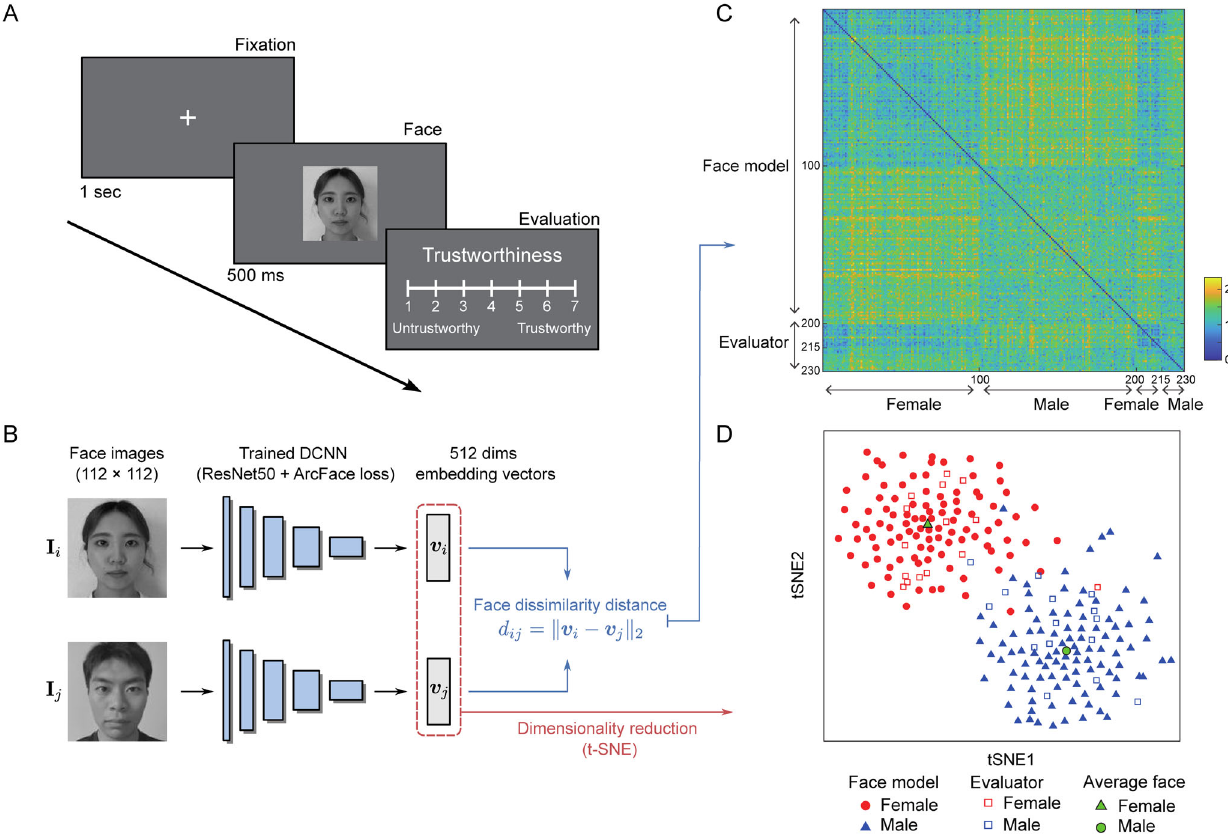
Fig. 1 Face similarity map depicting the distribution of face models and evaluators. A Protocol of the face evaluation task. After fi xation, a face photo was presented for 0.5s, and participants were asked to rate the trustworthiness of it. B Calculation of a 512-dimensional embedding vector for each face using the pretrained Deep Convolutional Neural Network (ArcFace). C Face dissimilarity distance ( L 2 distance) matrix for all face model-evaluator pairs. D A t -distributed stochastic neighbor embedding (tSNE) map compressing the 512 dimensions of the embedding vector of all participants into two